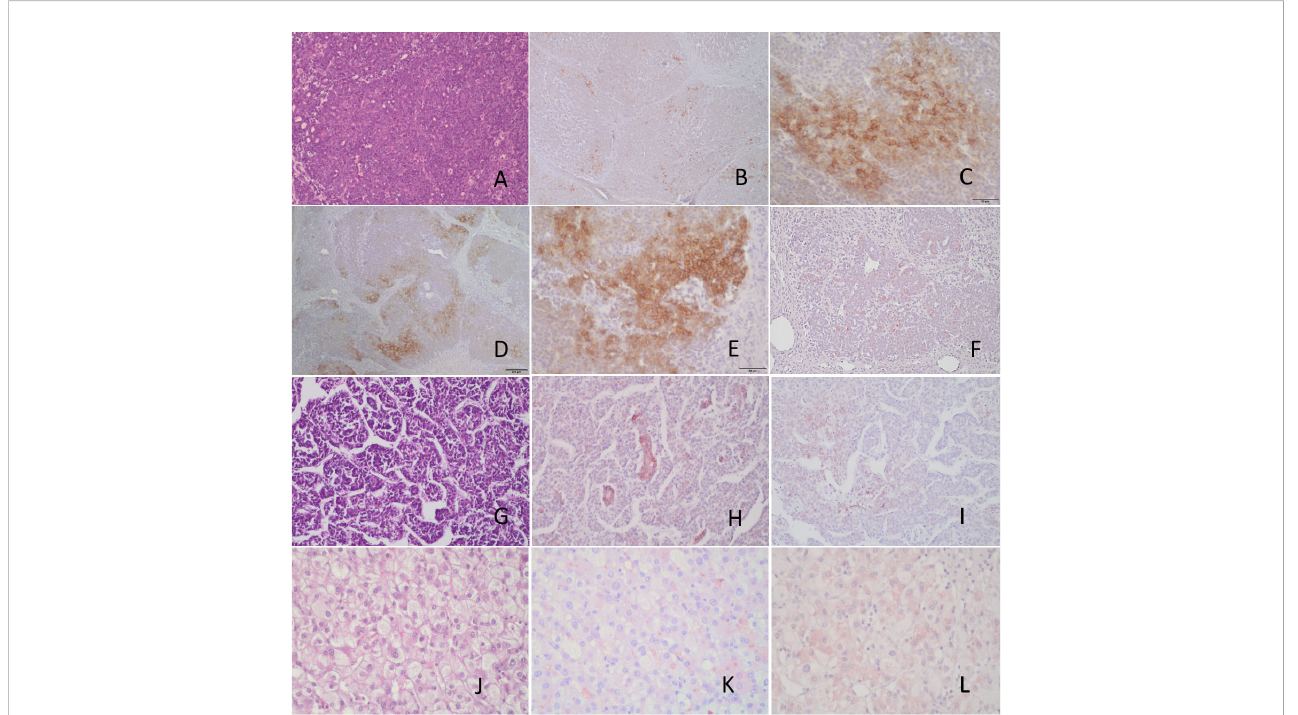
FIGURE 9 Immunohistochemical analysis of CD203c and CD326 expression by hepatoblastomas. (A) Epithelial hepatoblastoma diagnosed in a 18 month-old boy (stage 3, multifocal) H&E. (B, C) CD203 immunohistochemistry showing very focal membranous positive tumor cells. (D, E) CD326 immunohistochemistry demonstrating also focal positive cells (membranous) in the periphery of the embryonal type tumor nodules. (F) the tumor is negative for CK19. (G) H&E stain of another hepatoblastoma, epithelial embryonal type diagnosed in a 5 yo female (Pretext stage 4), showing focal positive CD203c cells (H) and very focal, weak CD326 positivity (I) . Pure fetal hepatoblastoma (J) negative for CD203c (K) and CD326 (L) . Scale bars 50 m (C, E) and 200 m (D)